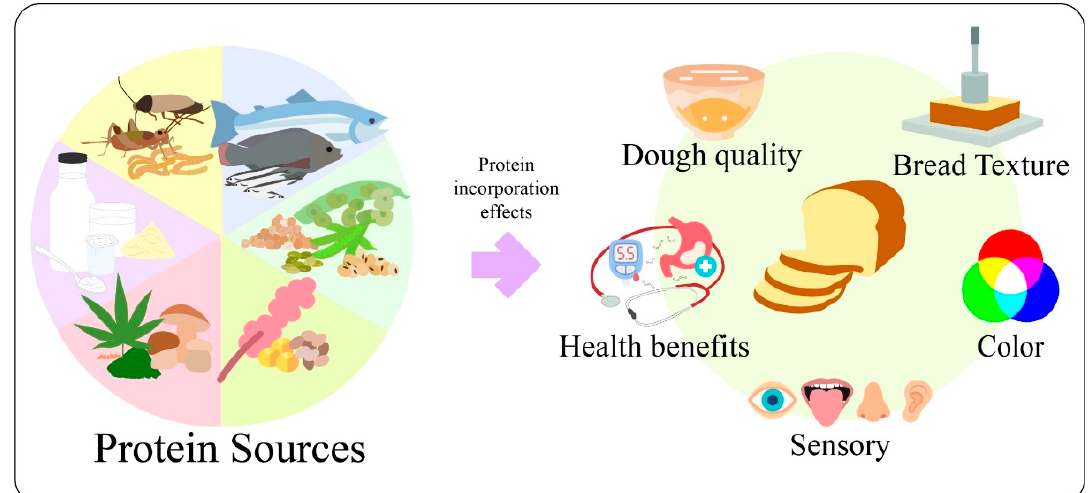
Figure 1. Protein sources (milk derivates, edible insects, fish derivates, legumes, cereals, pseudo- cereals, and other sources) and their effects on mass, process, final product, and